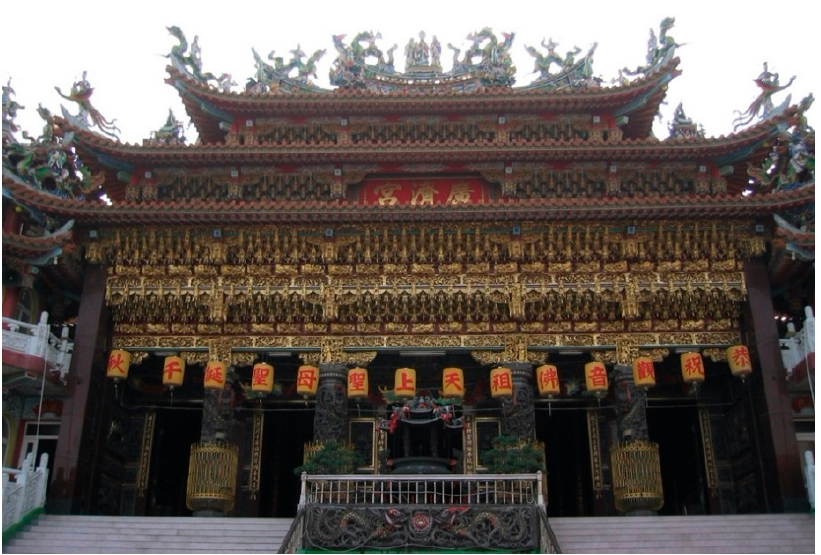
Figure 1. A Matsu temple where the goddess of the sea is worshipped, Chingshui, Taiwan. Photograph courtesy of Shin Yu Pai.